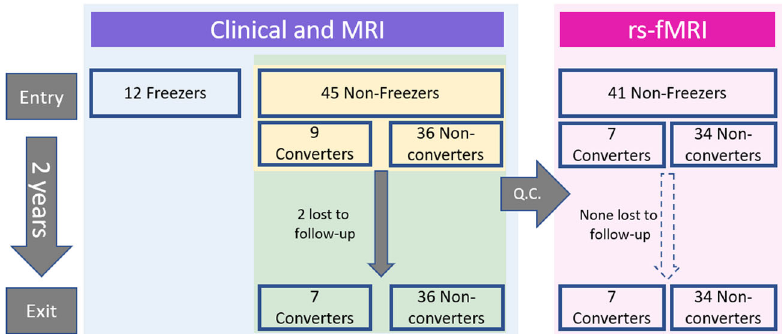
Fig. 1 Study fl owchart and analyses. Forty- fi ve non-freezers were included and followed up over two years. Of these, 9 participants developed FOG during these two years and were classi fi ed as converters. Twelve freezers were also included as a positive control group at study entry. Colored boxes indicate participants included in the main analysis (blue), prediction analysis (yellow), correlation analyses with clinical measures and thalamic sub-nuclei volumes (green), and functional connectivity analyses (pink). MRI Magnetic Resonance Imaging, rs-fMRI resting state functional MRI, Q.C. quality control for high